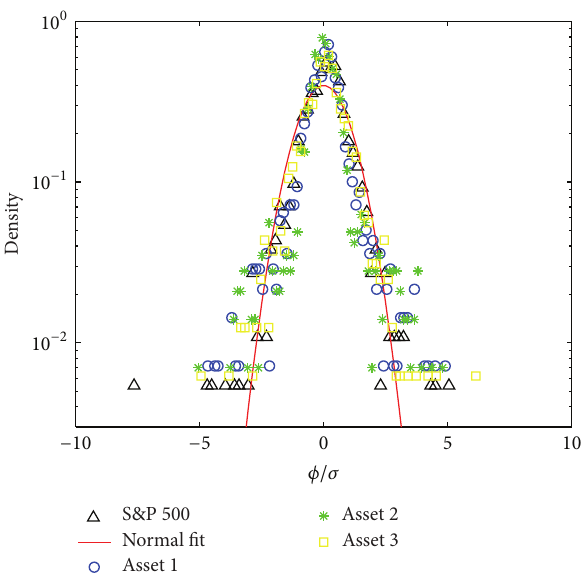
Figure 2: The probability density of S&P 500 returns and the simulatedstocksreturns.Theredlineisthenormalfittedcurve.Both S&P 500 returns and the simulated stocks returns show the fat-tailed distribution.